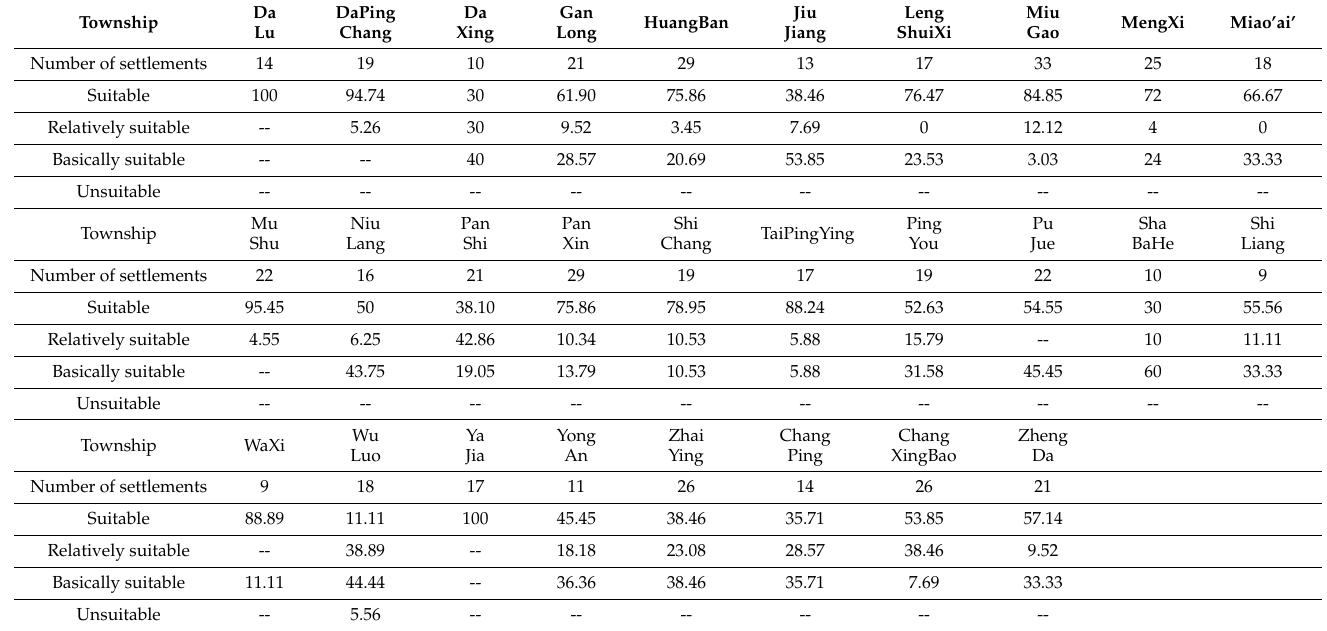
Figure 8. Suitability evaluation results of rural settlements in study area. Table 4. The suitability grade and proportion of rural settlements in each township (%).